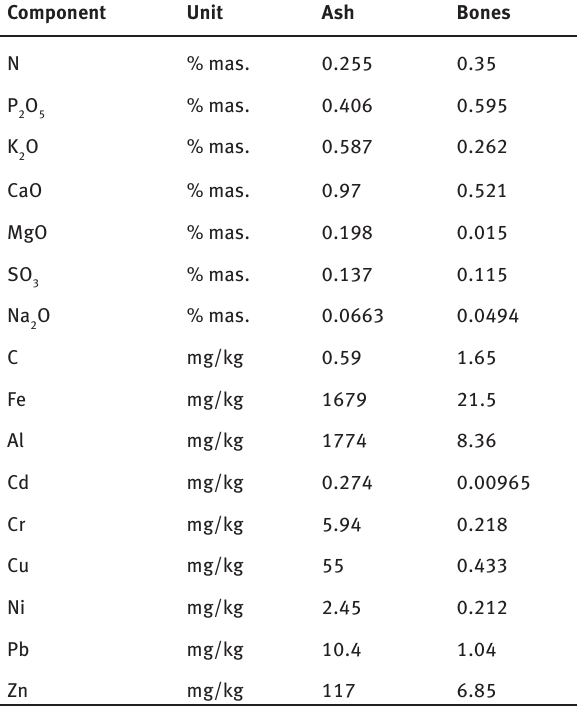
Table 2: Elemental composition of two fertilizer formulation based on the ash and